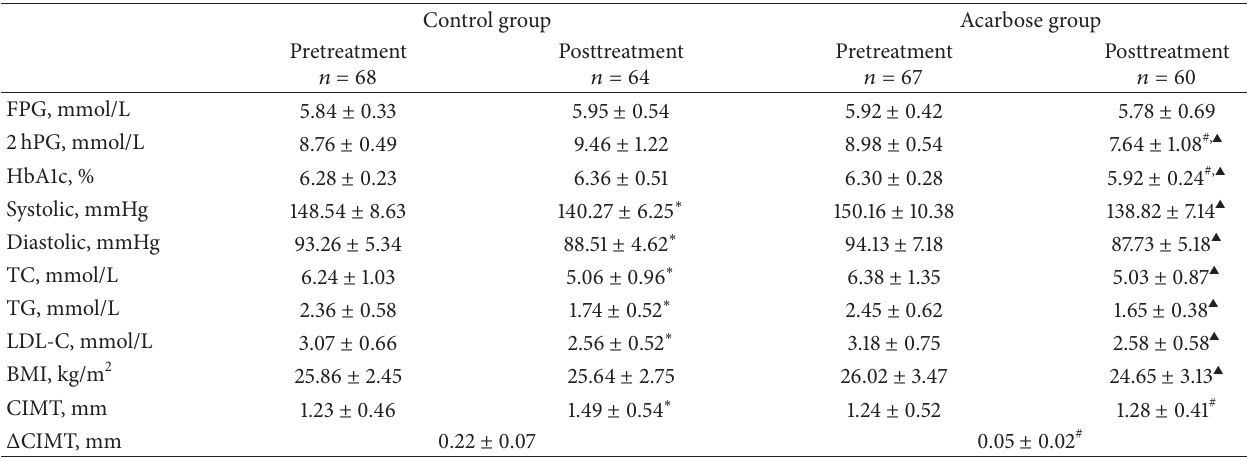
Table 3: Biochemical indicator level, CIMT, BMI, and blood pressure of two groups between pre- and posttreatment (mean ±